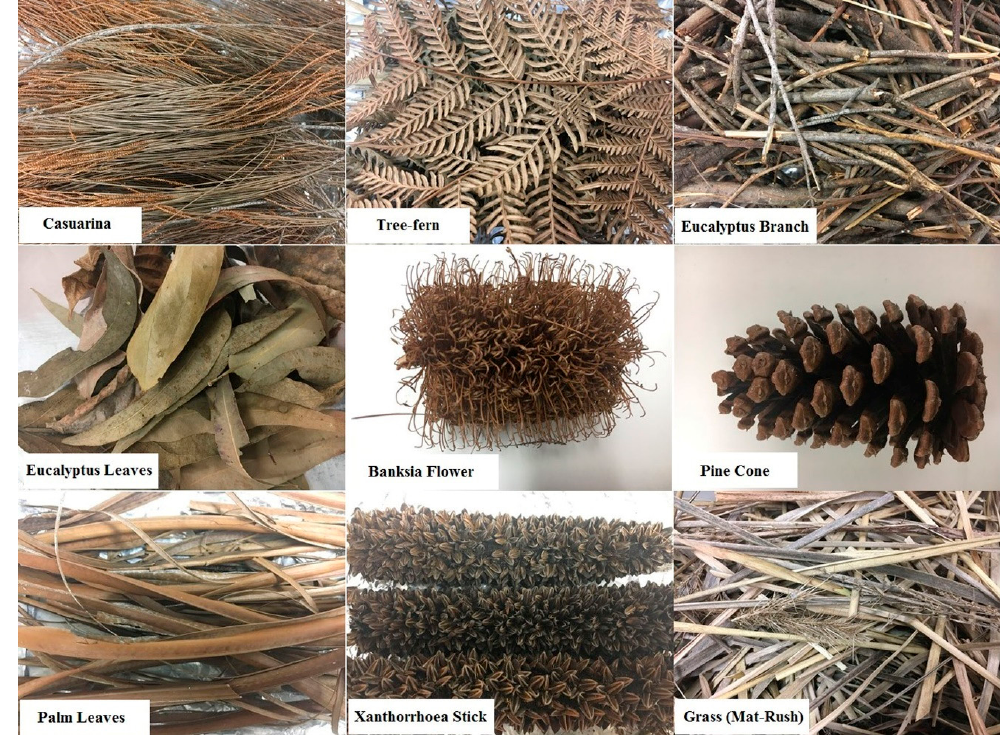
Figure 1. Biofuel types used in this project.